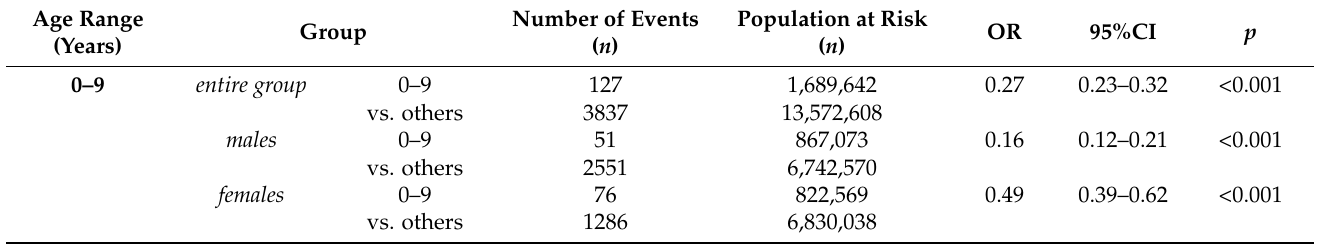
Table 1. Odds ratios (ORs) for the first shoulder dislocation event in residents living in rural